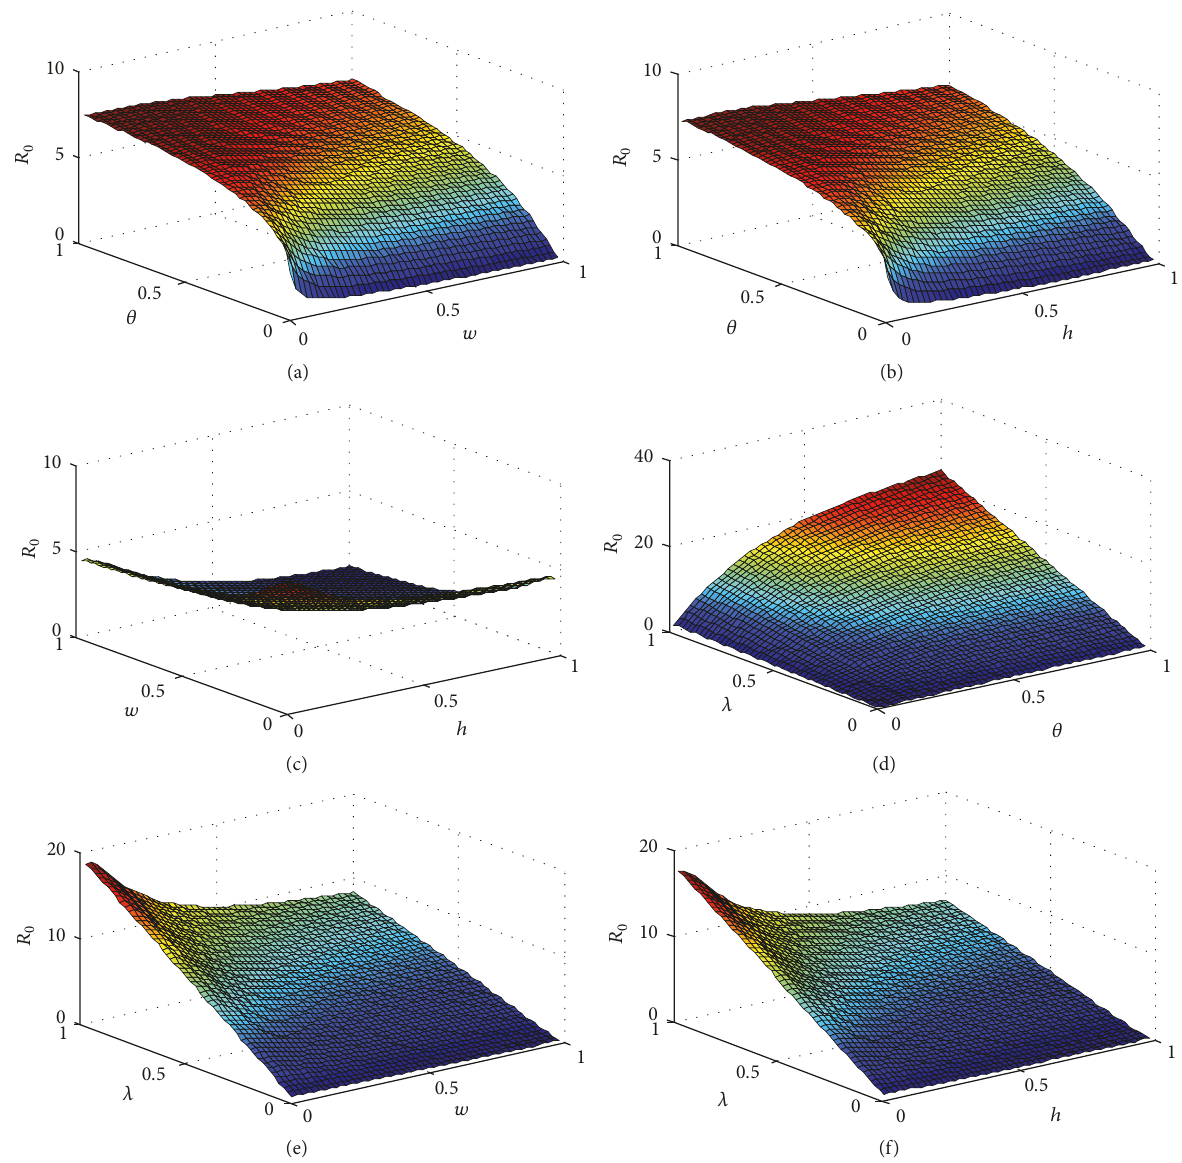
Figure 5: Effect of the interaction of information transparency factors on the evolution characteristics of food safety scare behavior: (a) the effect of the interaction between consumer concerns about food safety incidents 𝜃 and government food safety supervision information transparency 𝑤 on the evolution characteristics of food safety scare behavior diffusion; (b) the effect of the interaction between consumer concerns about food safety incidents 𝜃 and media food safety supervision information transparency ℎ on the evolution characteristics of food safety scare behavior diffusion; (c) the effect of the interaction between government food safety supervision information transparency 𝑤 and mediafoodsafetysupervisioninformationtransparency ℎ ontheevolutioncharacteristicsoffoodsafetyscarebehaviordiffusion;(d)theeffect of the interaction between the rate of information dissemination 𝜆 and consumer concerns about food safety incidents 𝜃 on the evolution characteristics of food safety scare behavior diffusion; (e) the effect of the interaction between the rate of information dissemination 𝜆 and government food safety supervision information transparency 𝑤 on the evolution characteristics of food safety scare behavior diffusion; and (f) the effect of the interaction between the rate of information dissemination 𝜆 and media food safety supervision information transparency ℎ on the evolution characteristics of food safety scare behavior